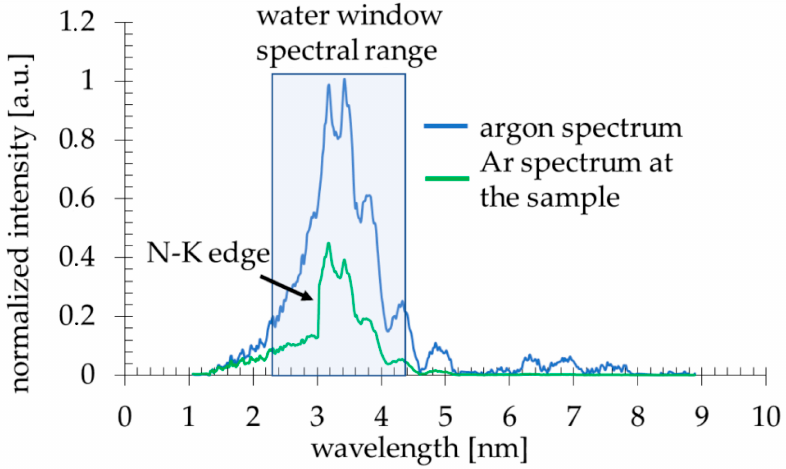
Figure 2. The Ar spectrum (the normalized intensity plotted versus wavelength) directly from the plasma ( ) and at the sample plane ( ).